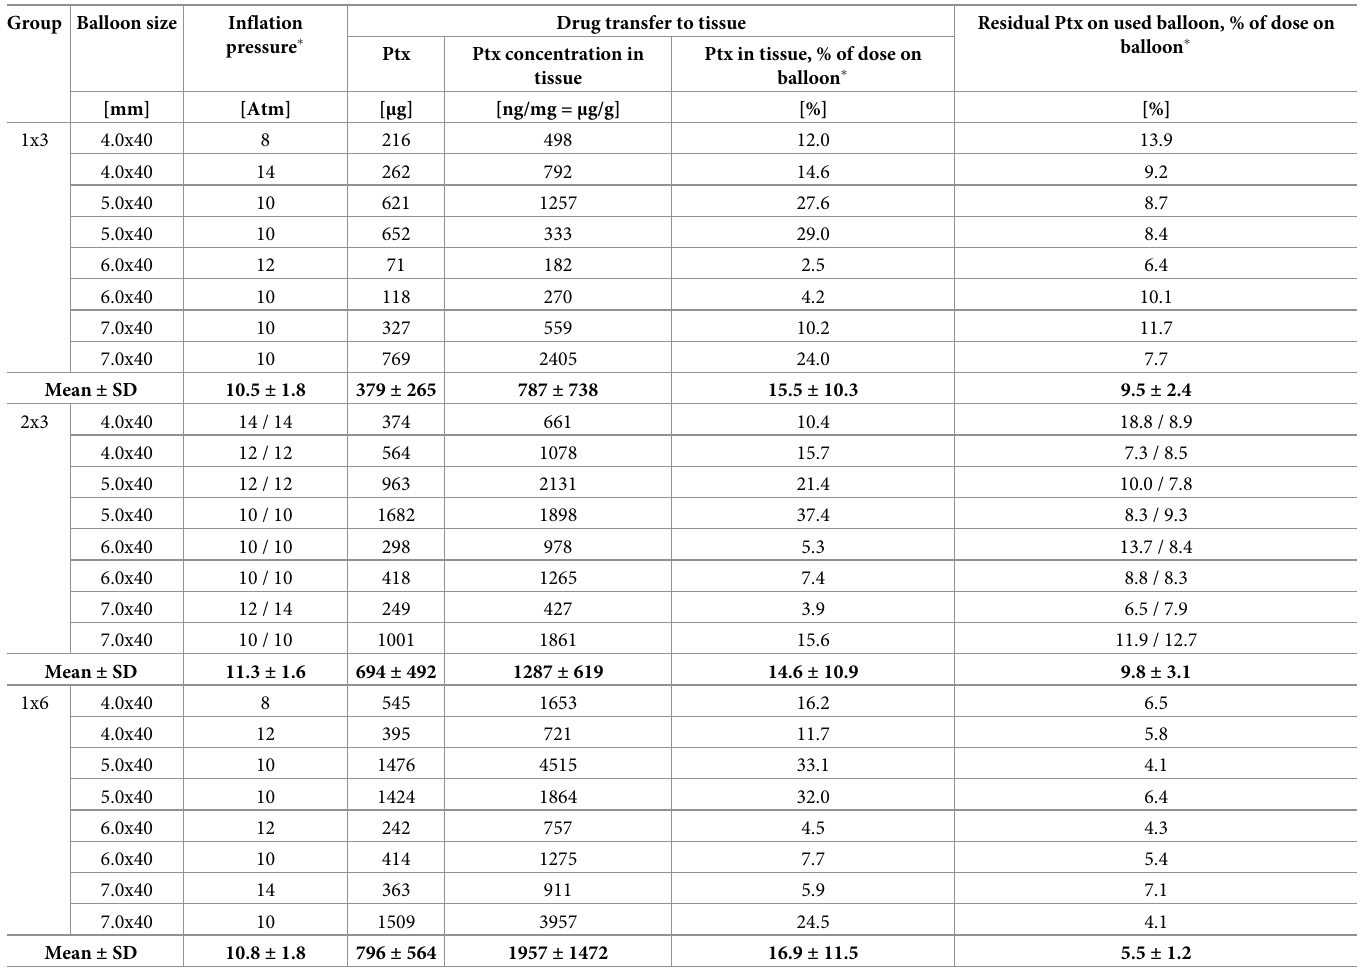
Table 2. Inflation pressure, Paclitaxel transferred to vessel wall and residual paclitaxel on balloon after treatment. Group Balloon